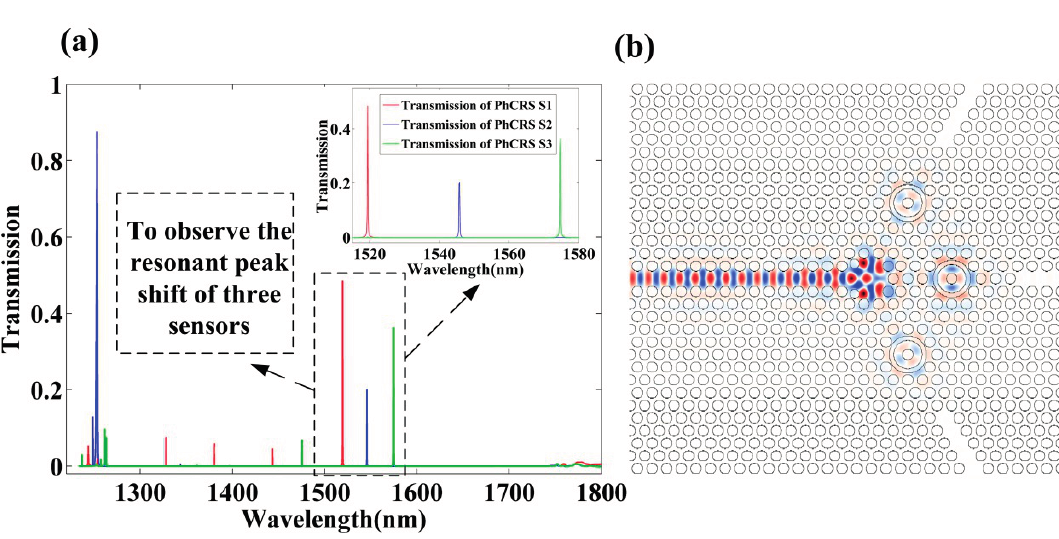
by black dashed line are chosen to observe the resonant wavelength shift of integrated three sensors